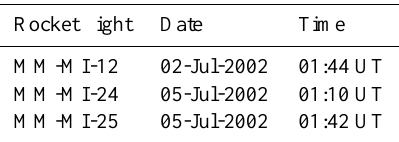
Table 1. Experimental parameters of the ALWIN MST radar used during the MIDAS/MaCWAVE campaign.